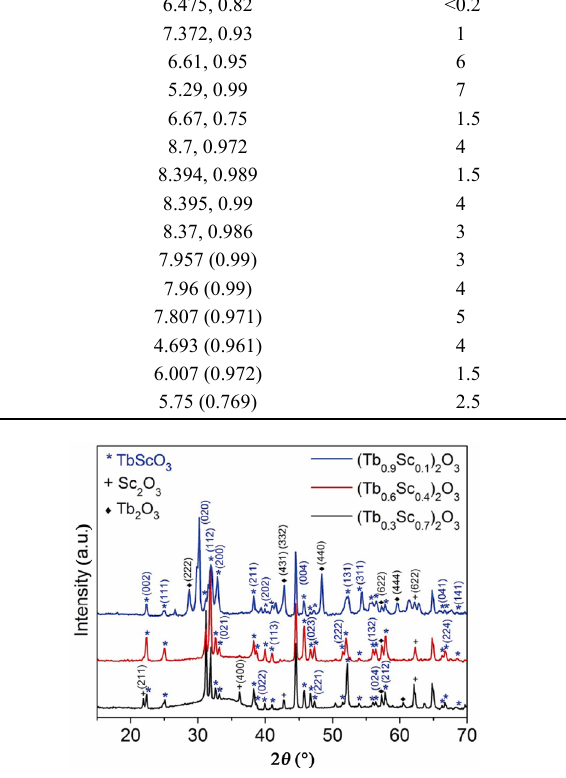
Fig. 5 XRD patterns of (Sc 1– x Tb x ) 2 O 3